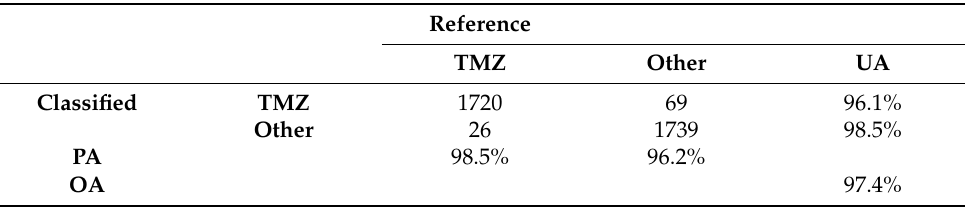
Table 1. Confusion matrix of the whole validation samples. OA, UA and PA represent overall accuracy, user accuracy and producer accuracy, respectively.